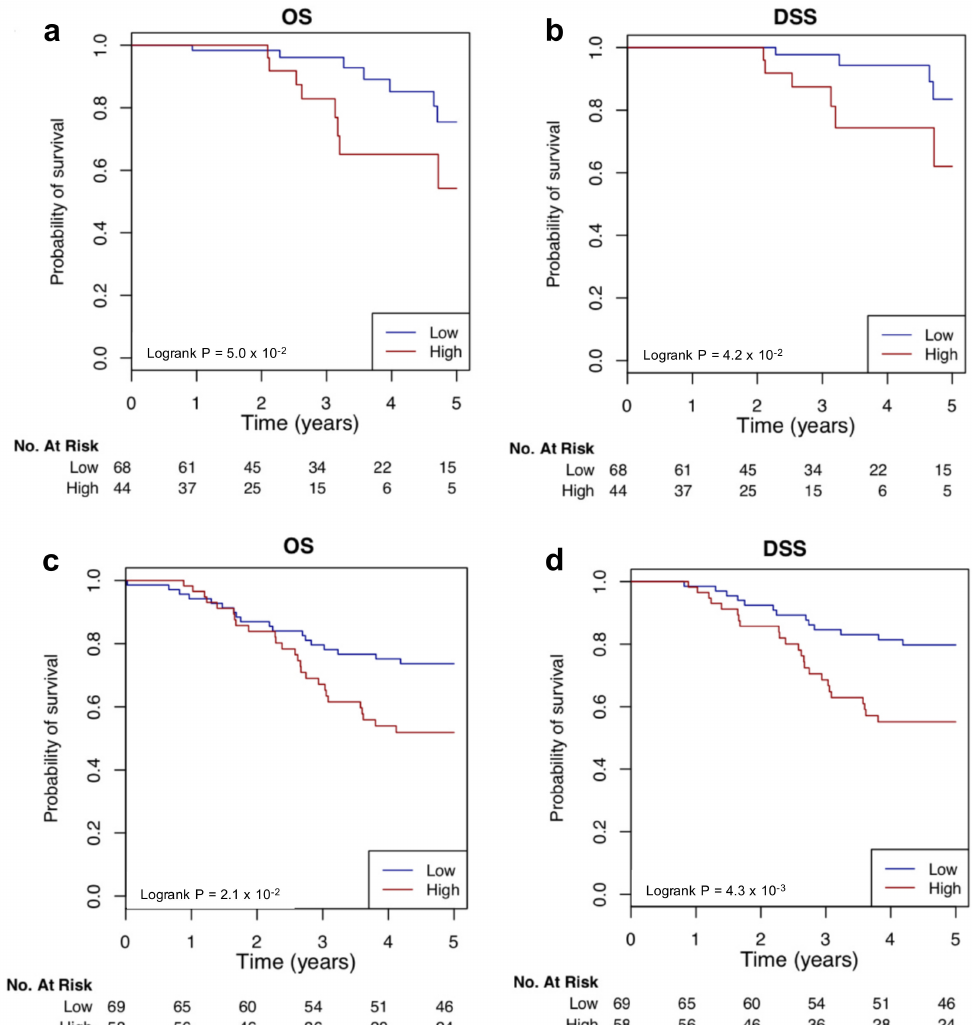
Figure 6. Survival analysis of the 31 gene YMR signature. TN patients were divided into high-risk (“High,” red line) and low-risk (“Low,” blue line) groups according their YMR signature scores. Survival fractions as a function of survival time (years) were then plotted for the two groups and the significant separation of the two curves were assessed by log-rank test. The YMR signature was tested using TNBC samples of TCGA and METABRIC datasets separately by the R package survcomp. The YMR signature can significantly stratify the 112 TCGA TNBC samples into high- and low-risk groups by both overall survival (OS) ( a ) and disease specific survival (DSS) ( b ). The YMR signature can also significantly stratify the 127 METABRIC TNBC samples into high- and low-risk groups by both OS ( c ) and DSS ( d